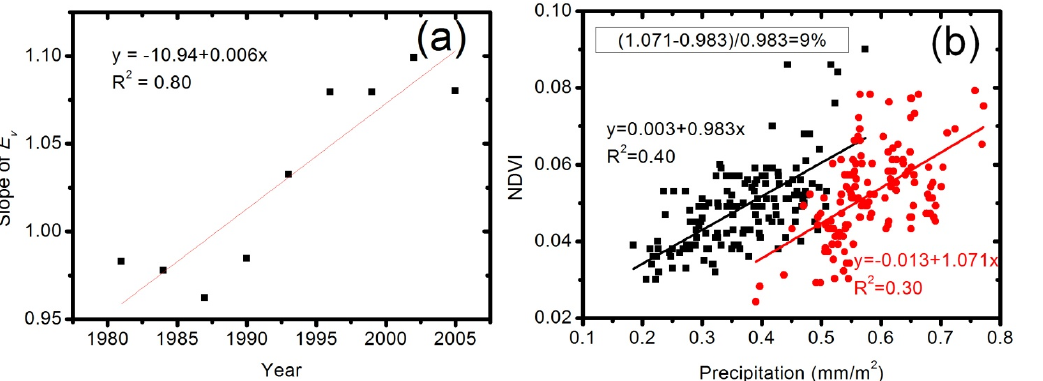
Figure 6. ( a ) Trend of Slope of E v from 1981 to 2007 and ( b ) Slope of E v in 1981 (black) and 2007 (red), with a relative increasing rate of